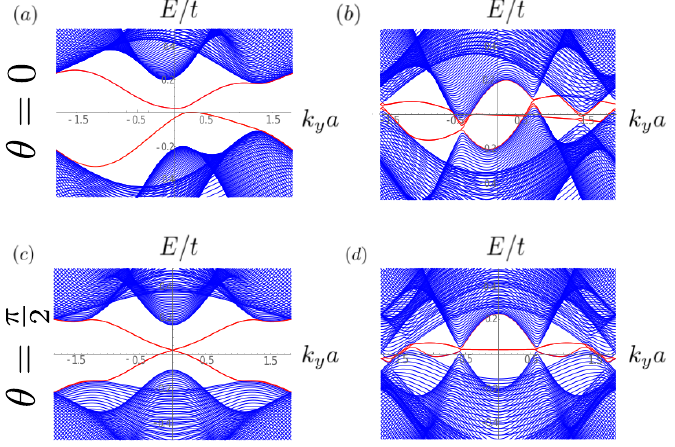
Figure 5: Energy spectra of AC nanoribbons in the presence of Rashba SOC and an applied magnetic field in x -direction ( θ = 0) [ (a) and (b) panels ] and y -direction ( θ = π/ 2 ) [ (c) and (d) panels ] . We used B = 0.8 | t | in the topological insulator (cid:107) phase, and B (cid:107) = 1.2 | t | in the crystalline Weyl semimetal